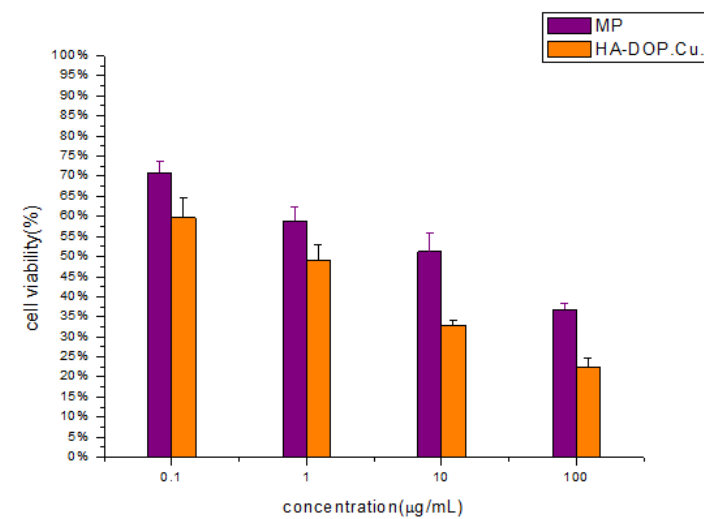
Figure 10. In vitro cytotoxicity of HA-DOP-Cu-MP nanoparticles and 6-MP at various concentrations against A549 cells. Data are shown as the mean ± SD ( n = 3). The A549 cells were seeded at a density of 4 × 10 3 cells / well in 96-well microtitre plates. The cell viability of the cells was measured after 48 h by 3-(4,5-dimethylthiazol-2-yl)-2,5-diphenyltetrazolium bromide (MTT) assay. Error bars are based on the SD determined via triplicate experiments ( n = 3).